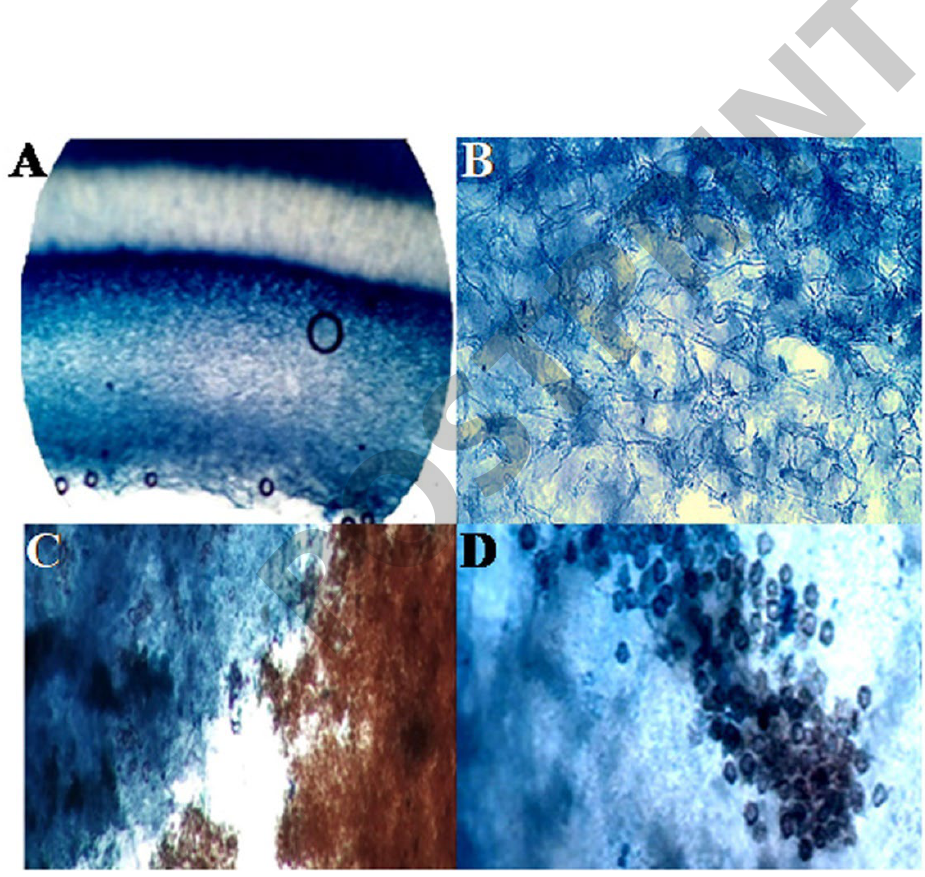
Figure 3 Images of the anatomy of Astraeus asiaticus - A. Cross-section of the gleba; B. Cross-section showing the arrangement of long thick-walled septate hyphal cells; C. spore mass; D. spore mass with basidiospore